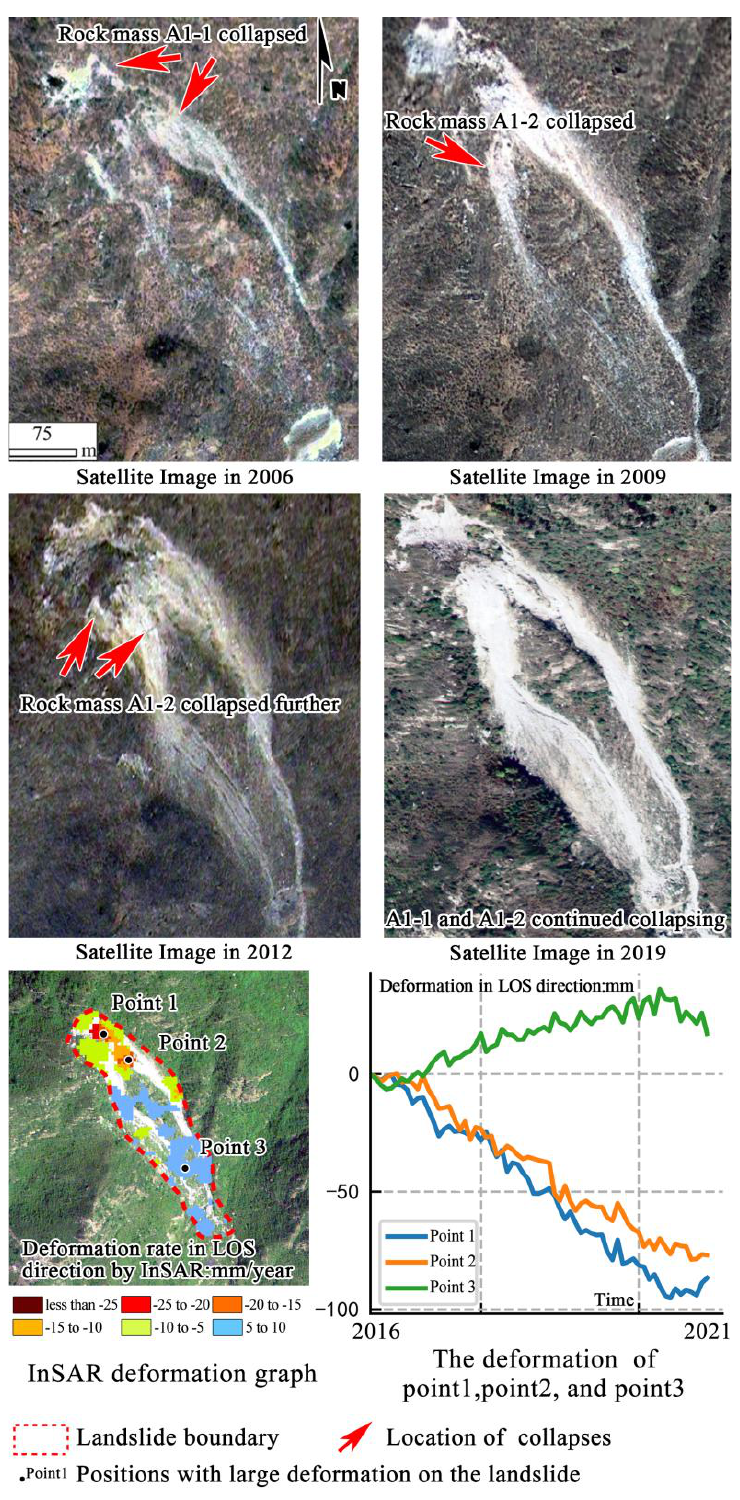
Figure 12. Optical images of landslide S11 acquired in 2006, 2009, 2012 and 2019 (the upper four panels). Deformation velocity of landslide S11 got by InSAR (left lower panel). The deformation in LOS direction of the three points during 2016–2021 are shown in the right lower panel.